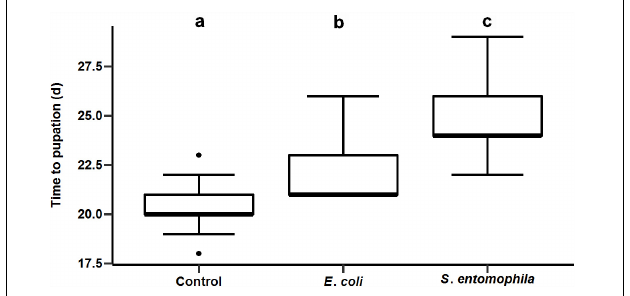
FIGURE 2 | Impact of orally administered bacteria on larval development. The developmental time until pupation of 49 uninfected control larvae, 49 larvae infected with E. coli , and 41 larvae infected with S. entomophila . Boxplots show median, interquartile, and total regions. Significant differences between groups are depicted by different letters (a–c).